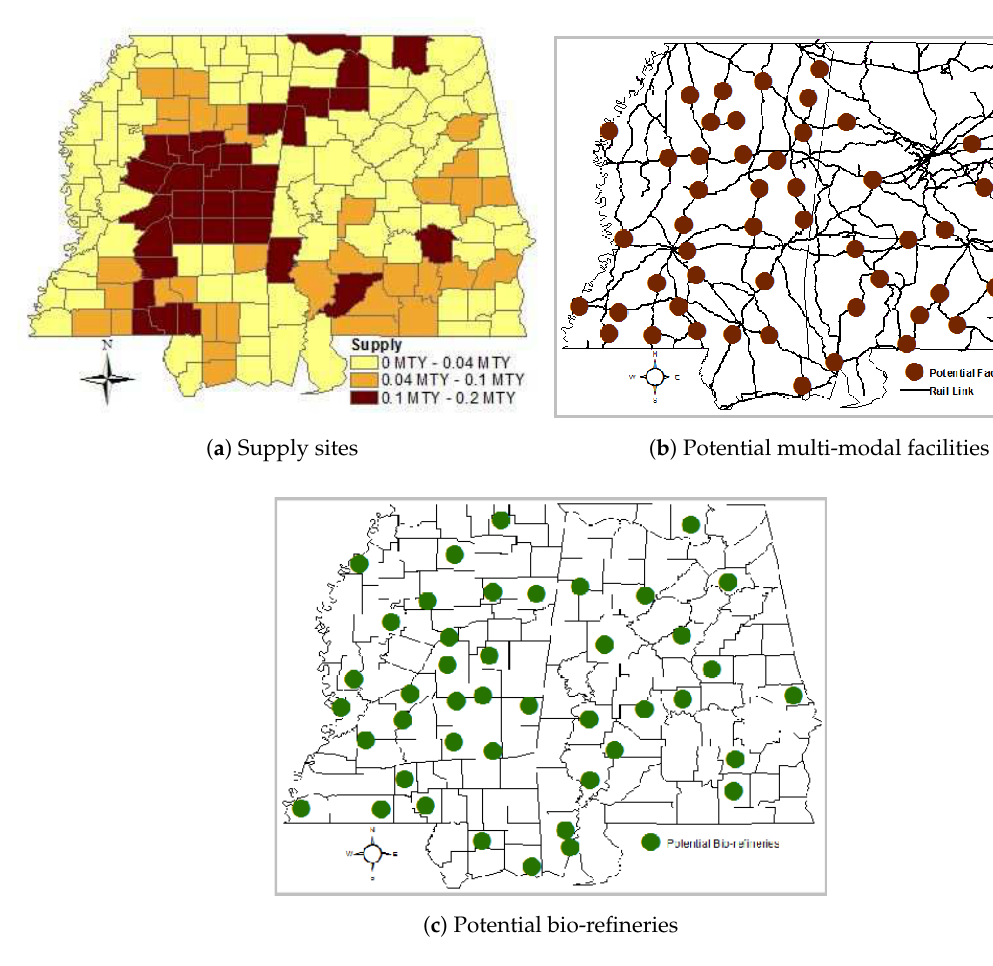
Figure 3. Biomass distribution and potential location of multi-modal facilities and